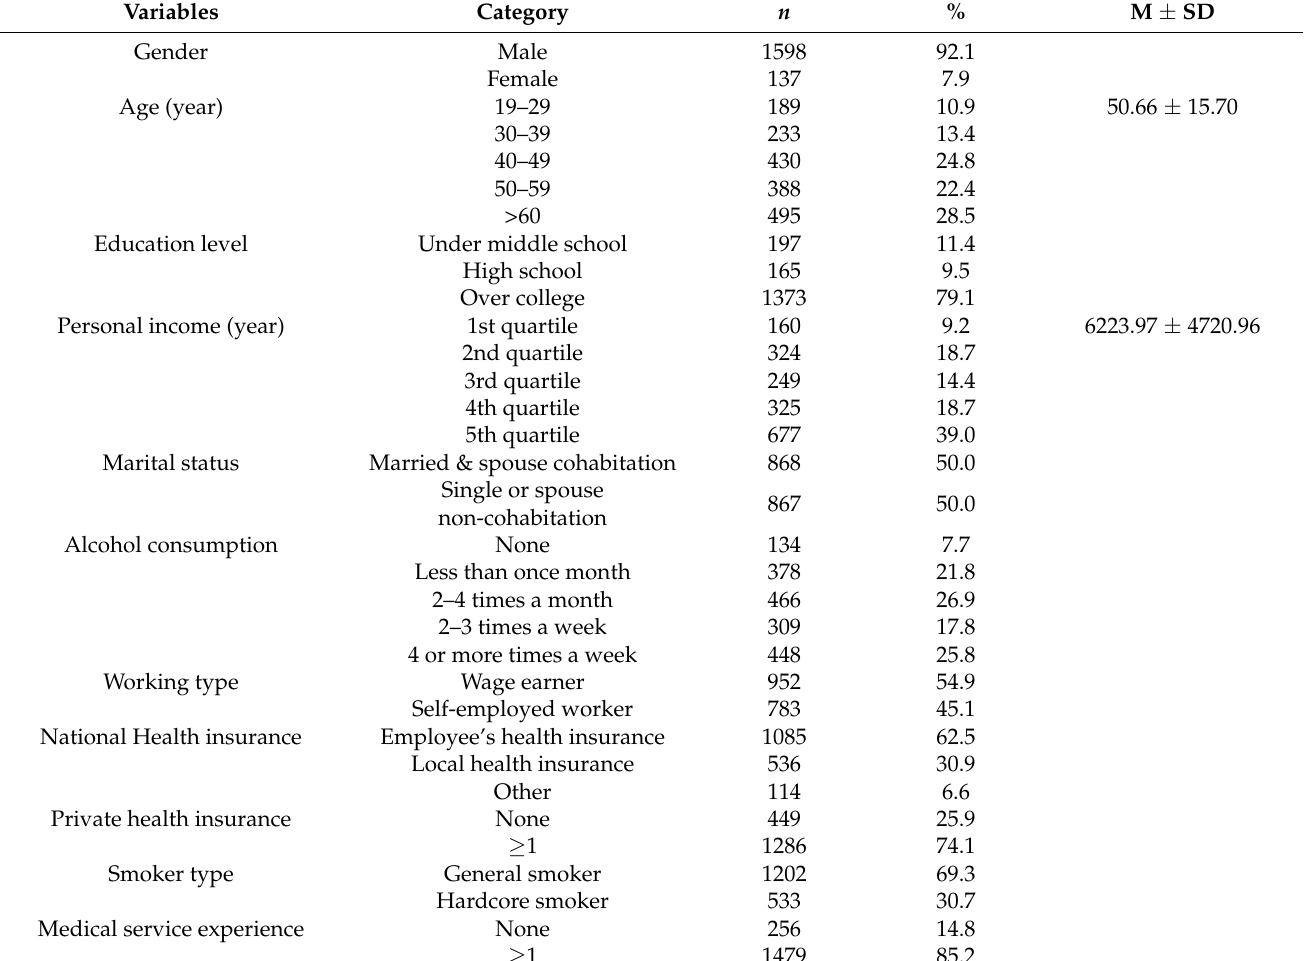
Table 1. General characteristics of study subjects before matching ( n =